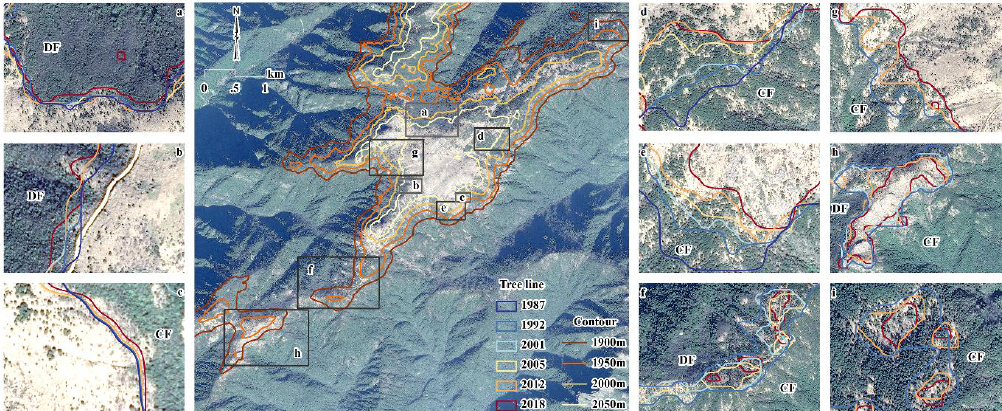
Figure 10. Local variations of tree line advancement along elevation (contour lines in main view of study area are 1900, 1950, 2000, and 2050 m). ( a ) – ( i ) Close-up views of corresponding spatial extent in main view; lines represent tree lines extracted in 1987, 1992, 2001, 2005, 2012, and 2018. Background is an RGB image downloaded from Google Earth with a 0.53 × 0.53 m spatial resolution that was acquired in 23 December 2014.